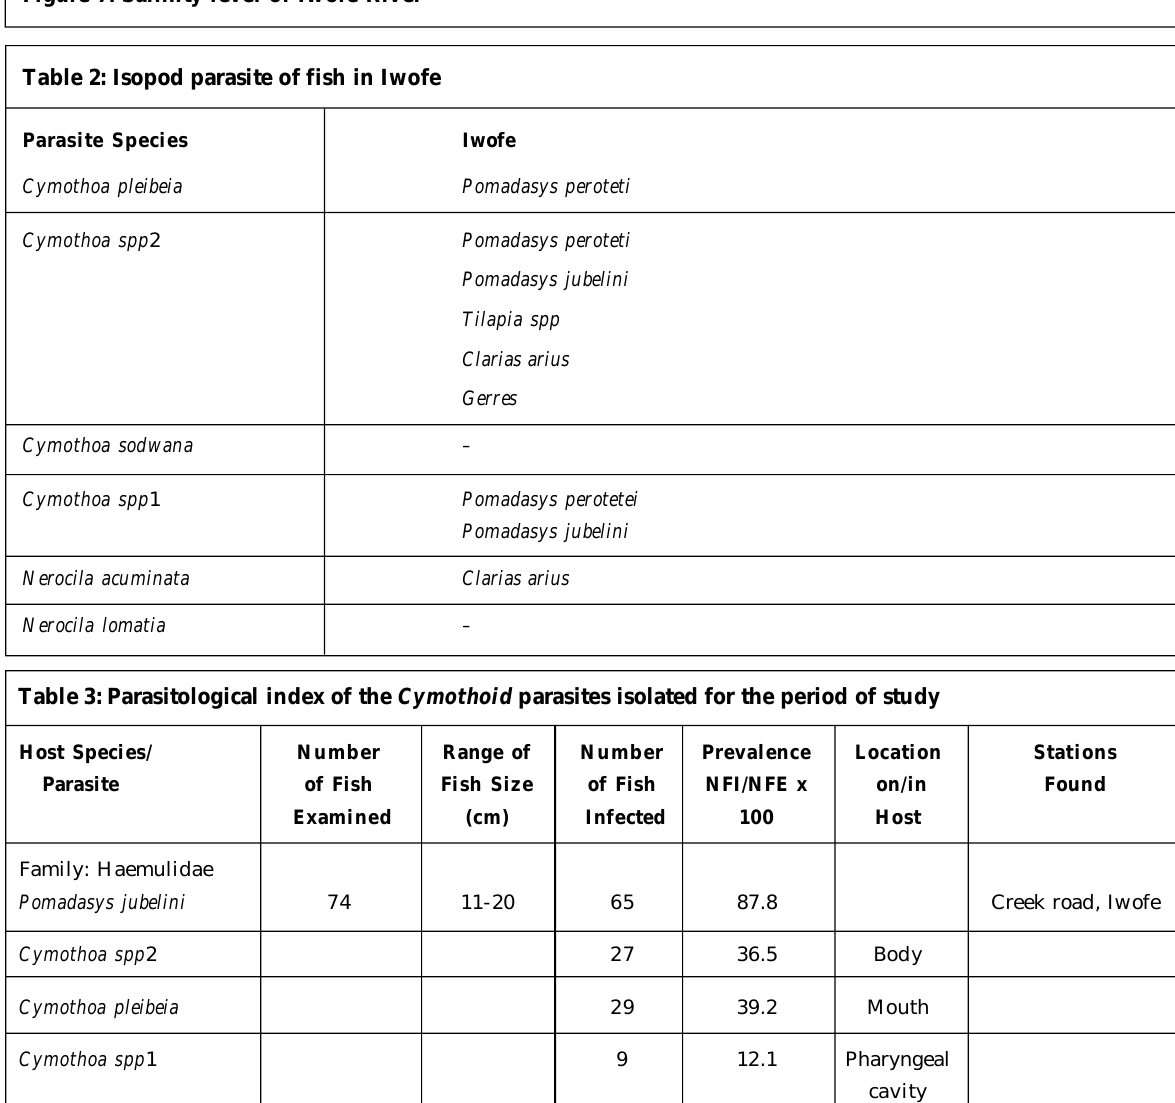
Figure 7: Salinity level of Iwofe River